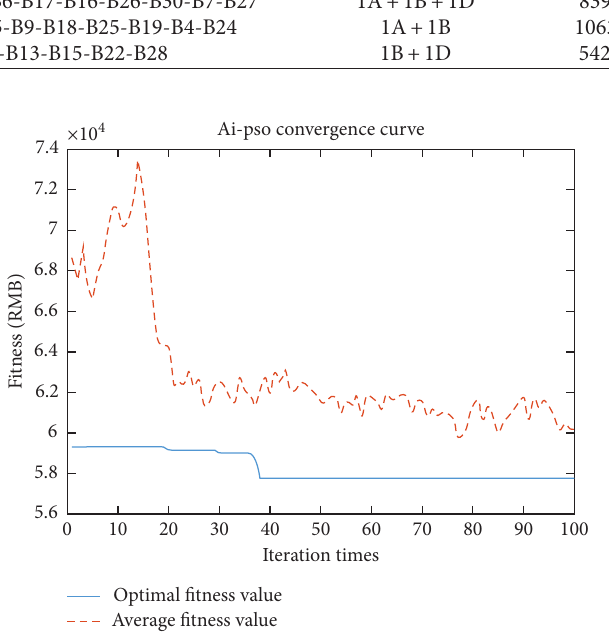
Figure 6: Convergence curve of AI-PSO in a static environment.